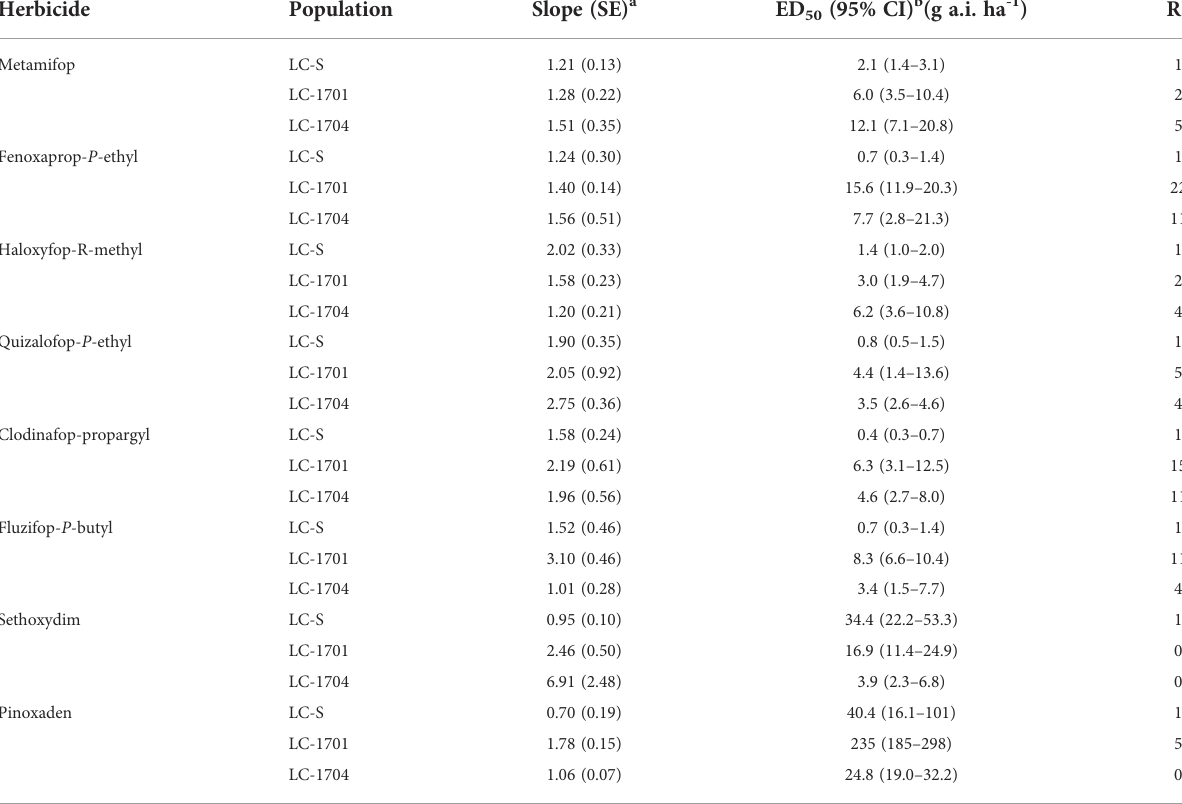
TABLE 3 Sensitivity to other ACCase-inhibiting herbicides in Leptochloa chinensis populations. Herbicide